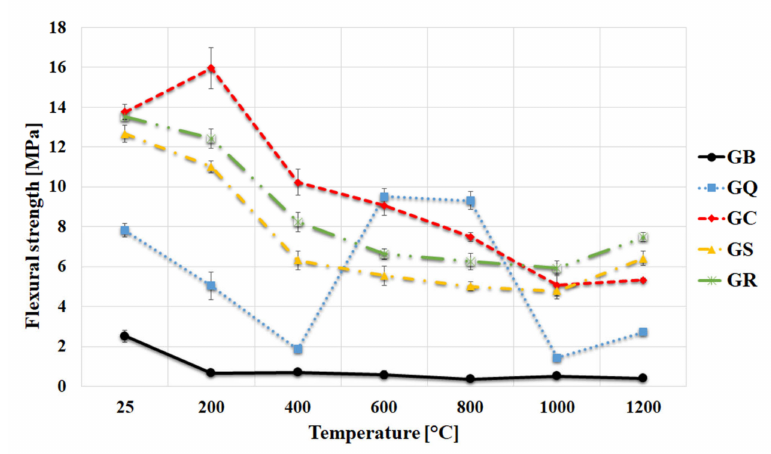
Figure 6. Flexural strength of the geopolymer binder and geopolymer composites at room temperature after exposure up to 1200 ◦